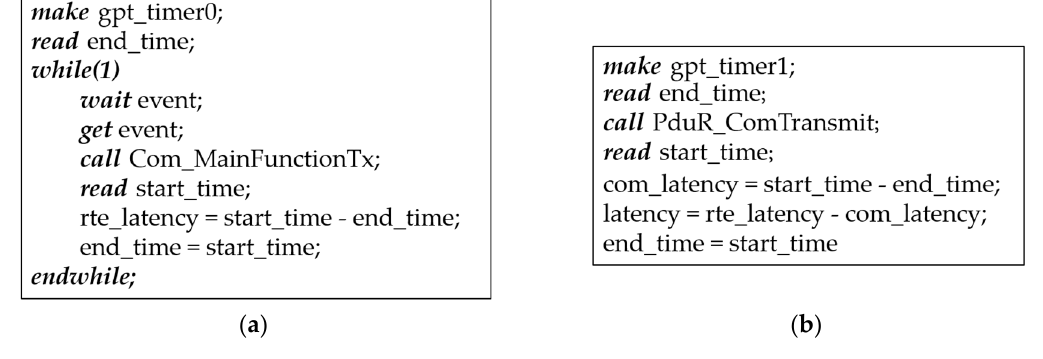
Figure 9. Pseudo code for measuring the latency of communication stack: ( a ) from Com module to Driver module; ( b ) from PduR module to Driver module.